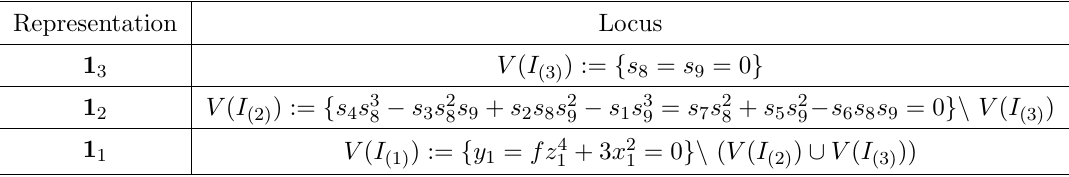
Table 12 . The loci for the charged matter representations under the U(1) symmetry. The charges are written as subscripts. The locus for the singlet 1 1 is given in terms of the sections x 1 , y 1 and z 1 given in appendix